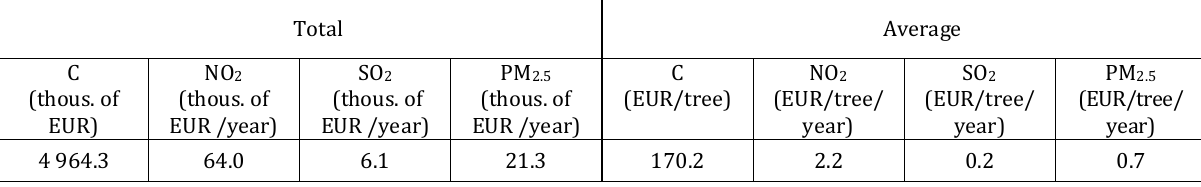
Table 3. Economic value of the analyzed ecosystem services for the trees included in the n=29,165 analysis, expressed by quartiles